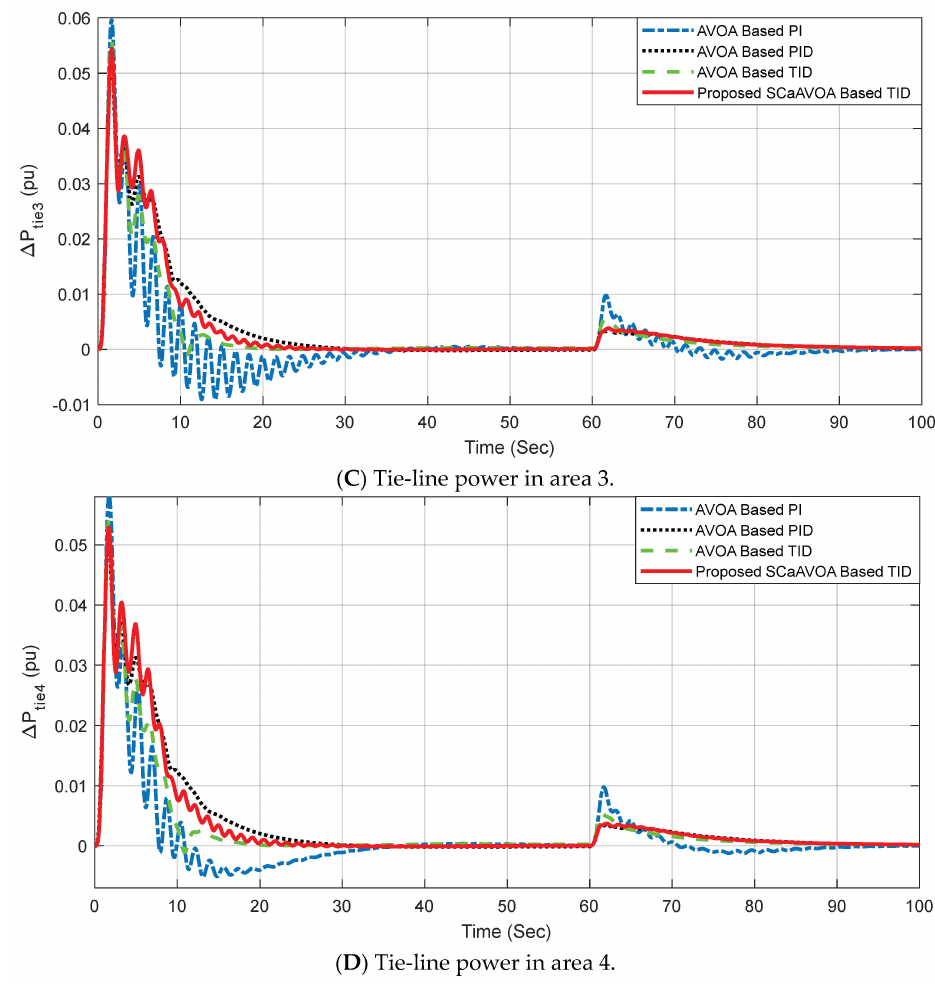
Figure 6. ( A – D ) System response for the five-area, ten-unit system with wind